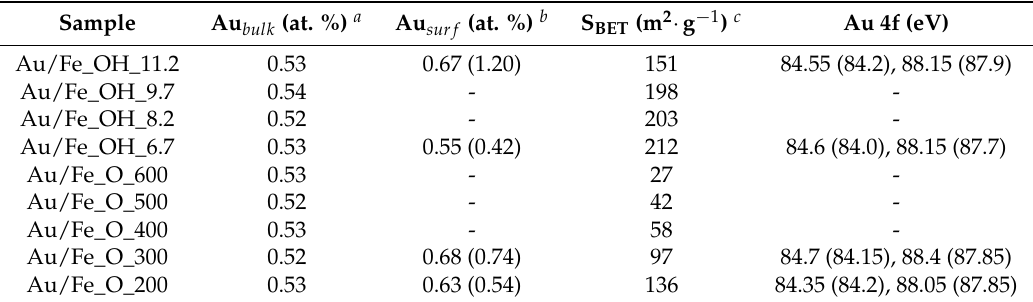
Table 1. Bulk Au concentrations (Au bulk ), surface Au concentrations (Au surf ), BET (Brunner ‐ Emmet ‐ Bulk Au concentrations (Au bulk ), surface Au concentrations (Au surf ), BET Teller) specific surface areas (S BET ) and Au 4f XPS peak positions of gold ‐ iron oxide catalysts. (Brunner-Emmet-Teller) specific surface areas (S BET ) and Au 4f XPS peak positions of gold-iron oxide catalysts.